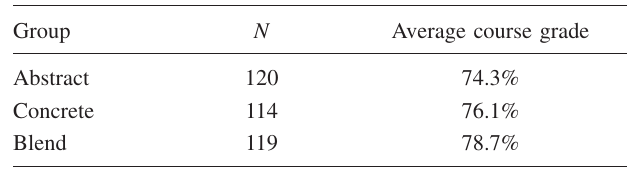
TABLE III. Within-domain study experimental groups.